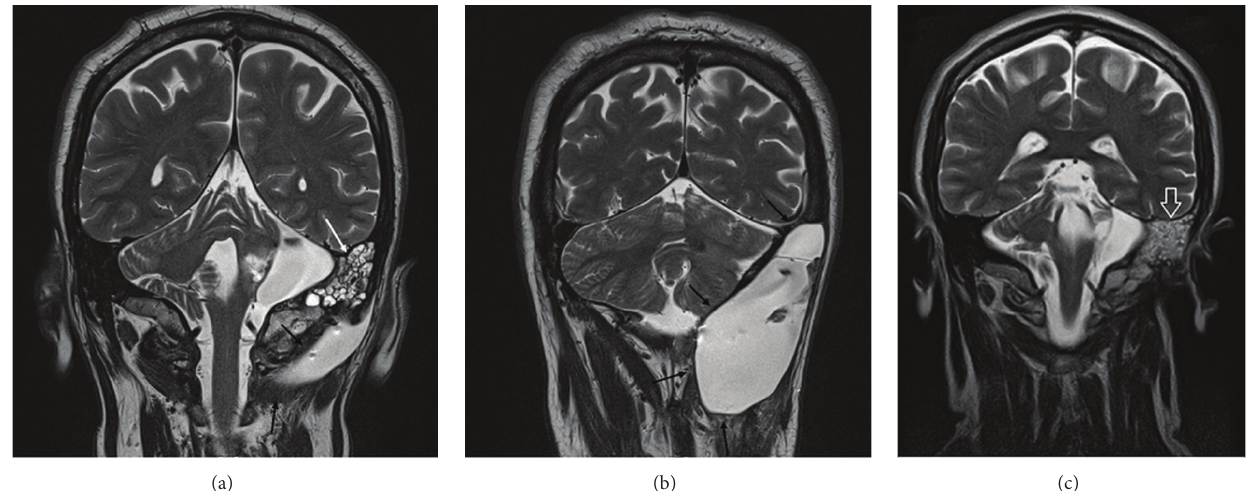
Figure 2: (a) Coronal T2-weighed image. Hyperintense CSF leak to the posterior skull base (black arrows). CSF leak in mastoid cells (white arrow). (b) Coronal T2-weighed image. Massive hyperintense CSF leak extended between the latera skull base and the fist cervical vertebra. Cerebellum compression visible (black arrows). (c) Postoperative coronal T2-weighed image. No CSF leak. Hyperintense signal to the mastoid air cells (white open